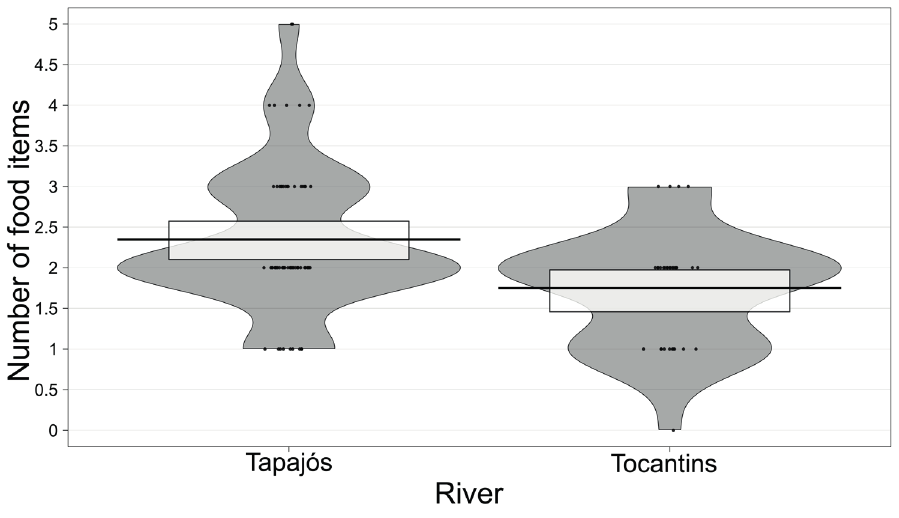
FIGURE 6 | The mean number of prey items of Plagioscion squamosissimus is cited by the interviewed fishers in the Tapajós and Tocantins rivers. Mean (dark vertical line), data distribution (bean gray area), data (points) correspond to individual fishers, confidence interval (rectangle). The median was 2 for both rivers.